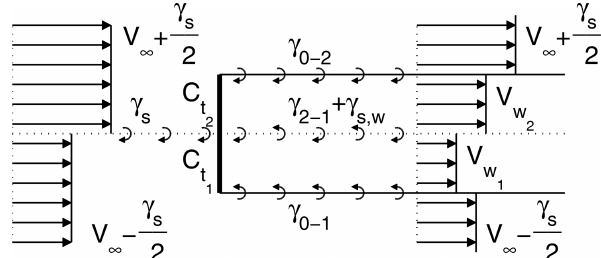
Figure 7. Schematic view of a non-uniformly loaded disc in a step shear generated by introducing an infinite vorticity sheet of strength γ s in the horizontal plane through the rotor